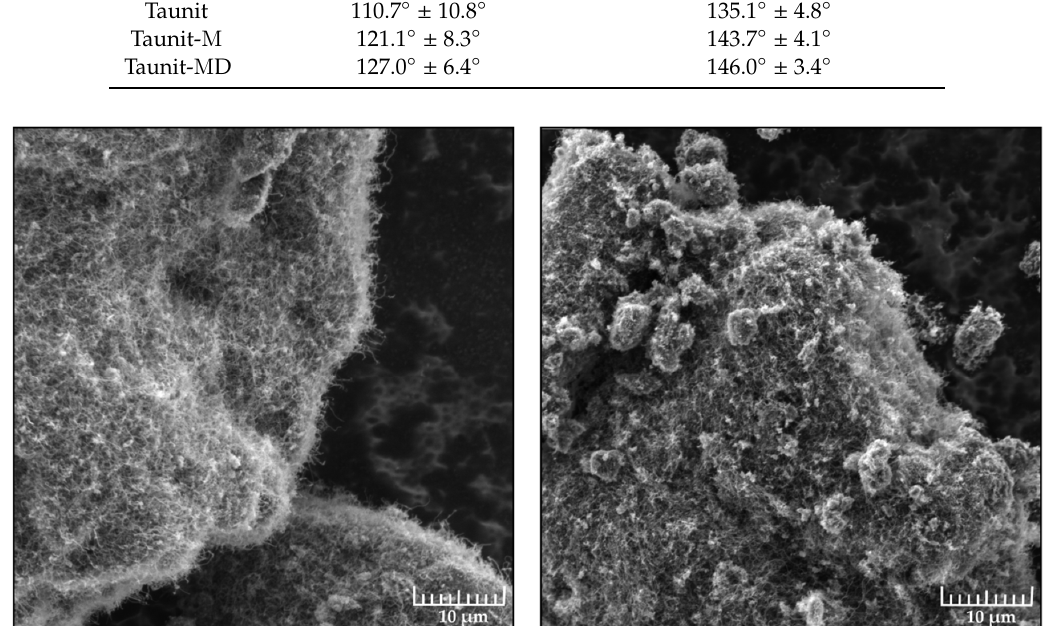
Table 2. Water contact angle of a droplet on a protective coating out of CNT agglomerates. Model